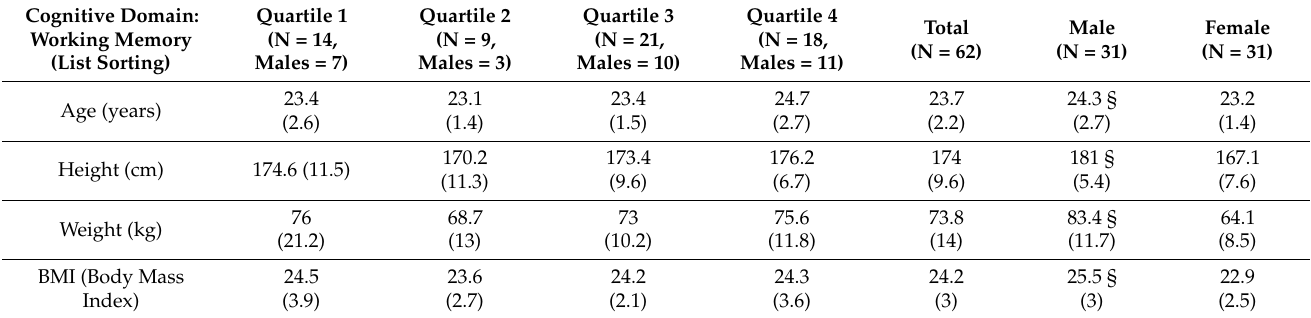
Table 4. Average (sd) age, height, weight, body mass index, activity levels, heart rate (HR), standard deviation of N–N interval (SDNN), low-frequency to high-frequency ratio (LF/HF), and List Sorting testing score shown for quartiles, total, males, and females. §: p < 0.05 of a comparison between males and